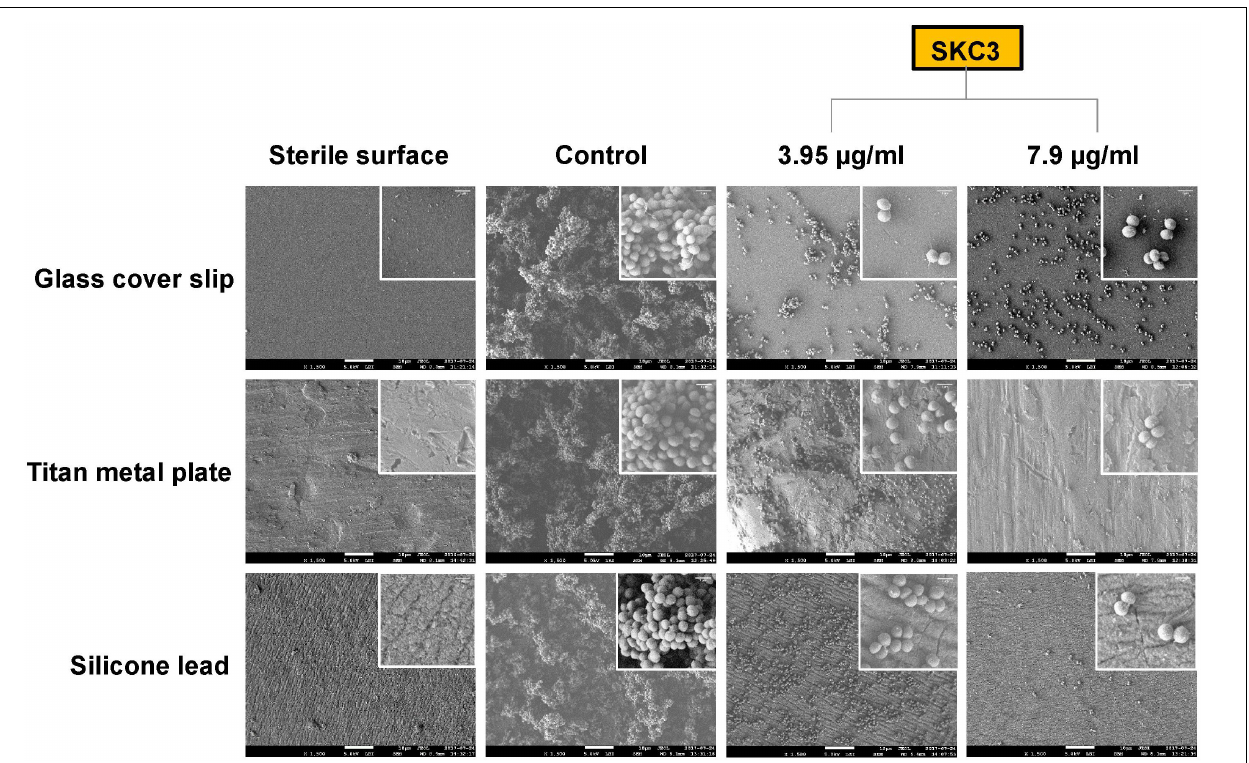
FIGURE 4 | Scanning electron micrographs of Staphylococcus epidermidis RP62A (24 h) biofilms on glass cover slips, titan metal plate and silicone tubes at × 1,500 magnification (scale bar: 10 µ m). Treatment with SKC3 at BIC 90 and 2 × BIC 90 significantly reduced the staphylococcal biofilm formation on these surfaces. No apparent changes in the morphology of RP62A (zoom in image) was observed at higher magnification ( × 10,000; scale bar: 1 µ